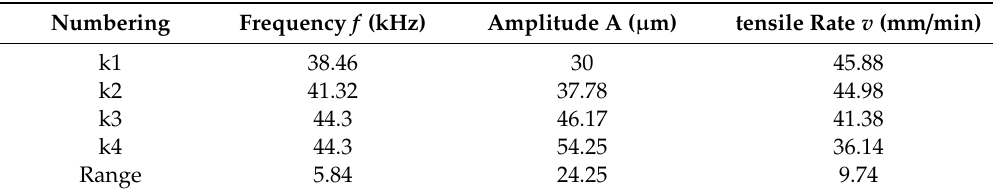
Table 10. The intuitive analysis table of the stress